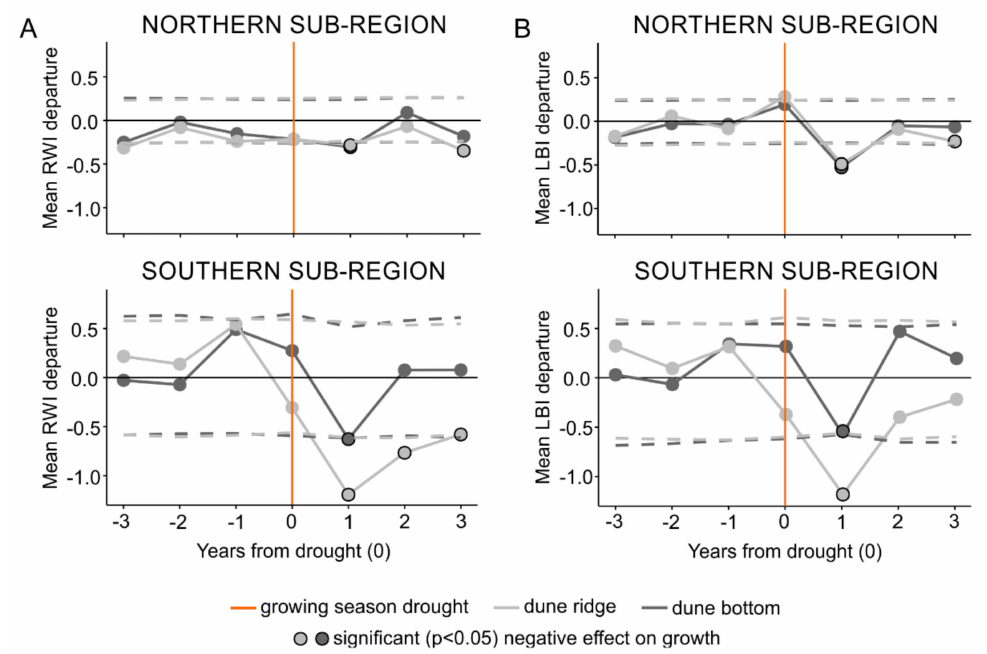
Figure 3. The results of the superposed epoch analysis for the subregion-specific droughts and the ridge-north, bottom-north, ridge-south, and bottom-south datasets of ring width ( A ) and latewood blue intensity ( B ) parameters. Light and dark gray represent dune ridge and bottom microsites, respectively. Orange lines show an event year (i.e., superposed subregion-specific droughts) and circles with black outline present significant negative effect on growth. Horizontal dashed lines represent significance threshold at p <